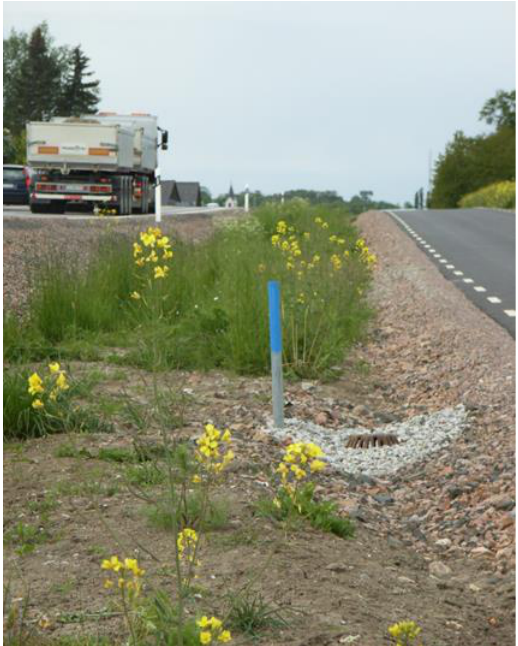
Figure 1. Feral oilseed rape plants growing alongside roads in Scania, South Sweden. Photo: J. Malm.